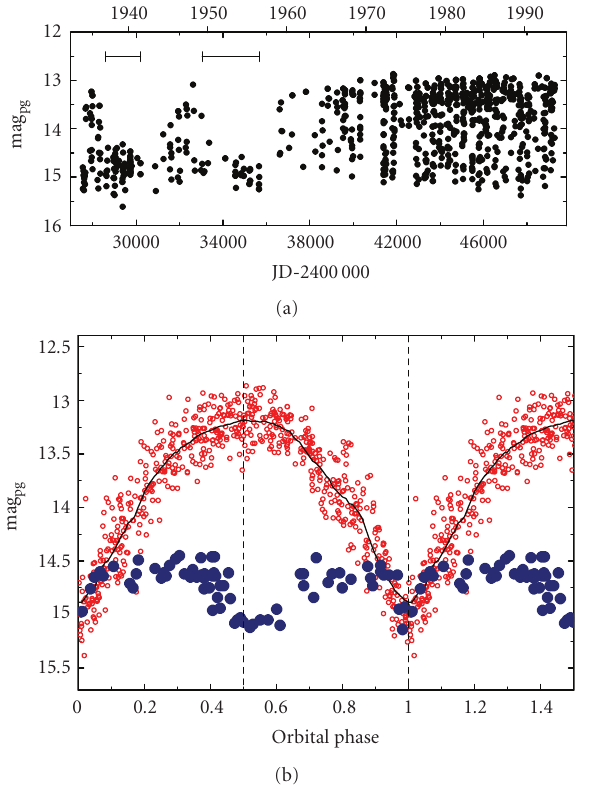
Figure 7: (a) The optical light curve of HZ Her/Her X-1, composed of 807 observations obtained with the D 40cm and D 17cm astrographs of the Sonneberg Observatory. The intervals of inactive states are marked by the horizontal bars. Adapted from [47]. (b) The orbital modulation of HZ Her. Open circles denote the extended active state between February 1959 and October 1993 [47]; the smooth line represents the moving averages of these data. Closed circles mark the orbital modulation in the low state observed by [45].